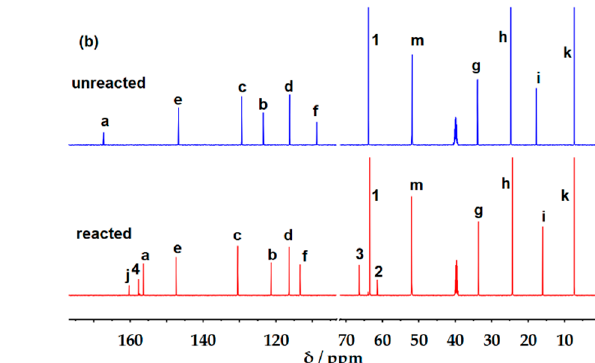
Figure 3. The 1 H– 13 C HMBC spectrum of [Et 4 N] [Car]:EG (1:2) + CO 2 . Letters from a to j are the labels of hydrogen or carbon atoms of Car-based carbonate. Letter m is the label of hydrogen or